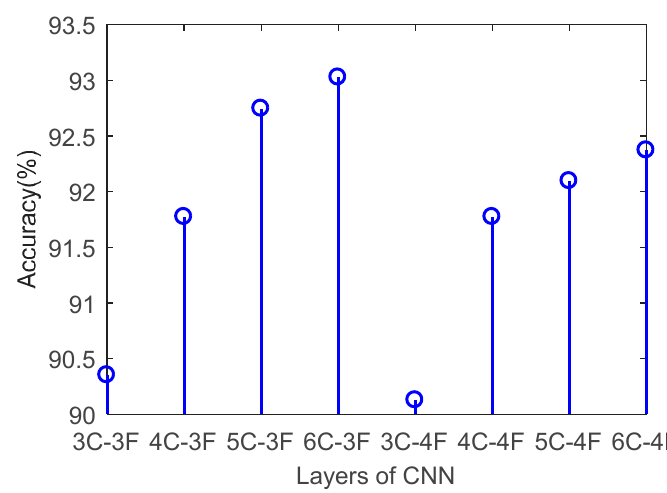
Figure 8. Validation on prediction accuracy with different layers using the testing set.